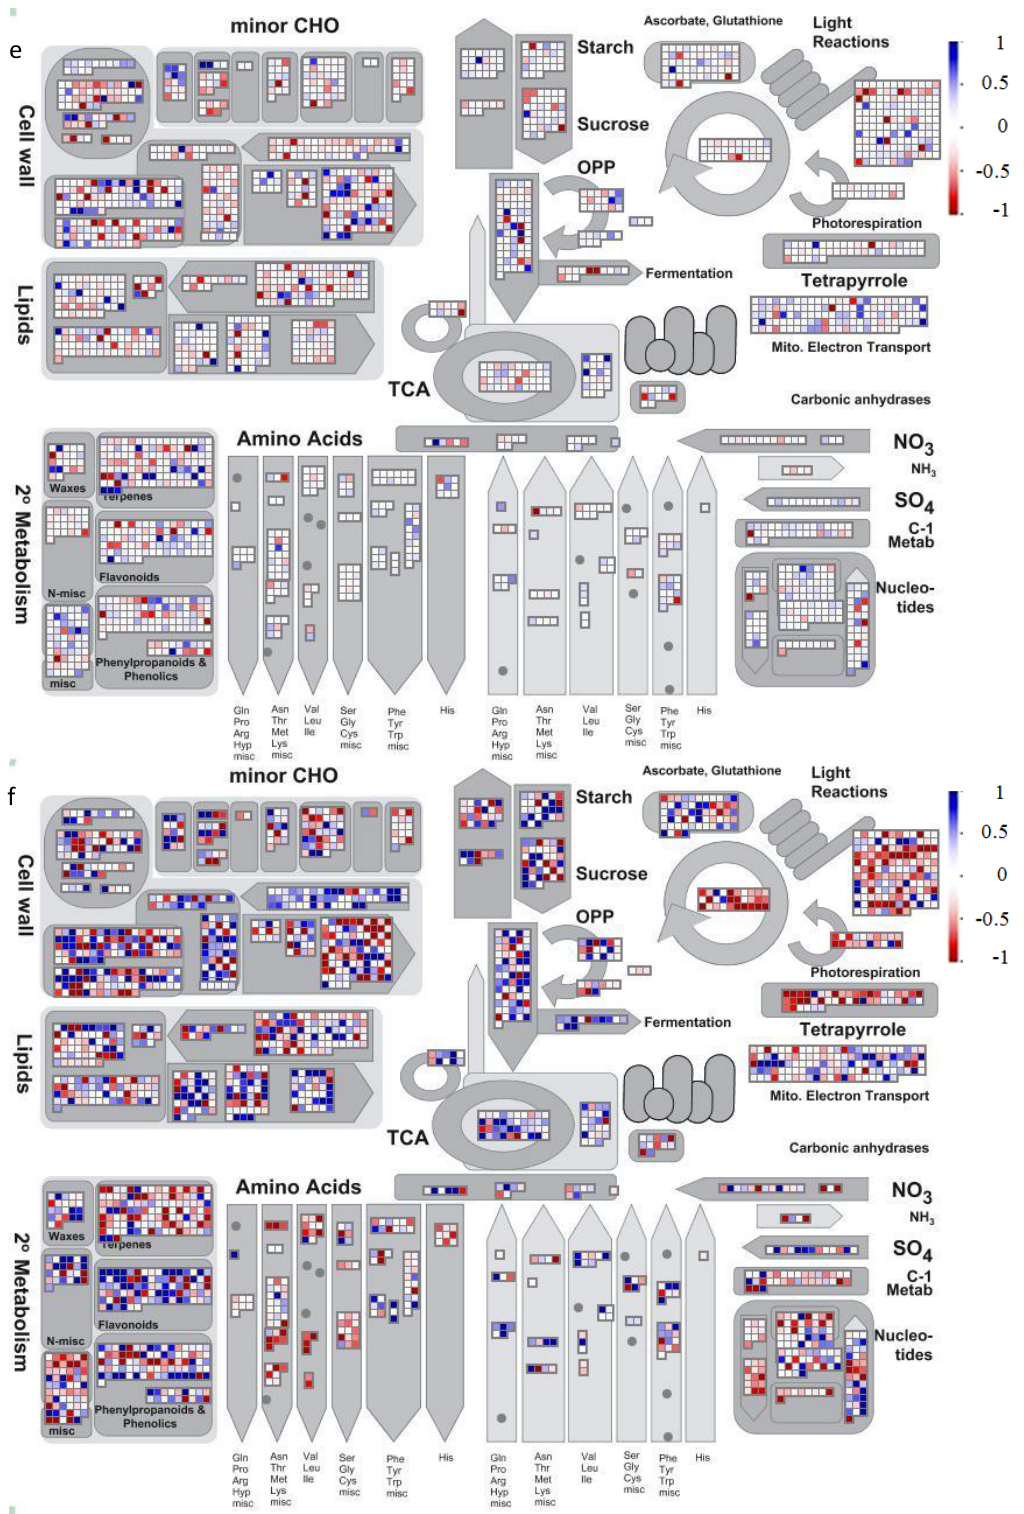
Figure 1. Metabolic pathway overviews for all the six abiotic stresses. M -value data in Table S1 for all the identified Arabidopsis genes were used to display in MapMan Image Annotator. Two color scale schemes were used; blue was to denote genes that were induced and red was to denote genes that were suppressed by ( a ) AgNPs; ( b ) Cold; ( c ) Drought; ( d ) Ag + (AgNO 3 ); ( e ) Heat; and ( f )